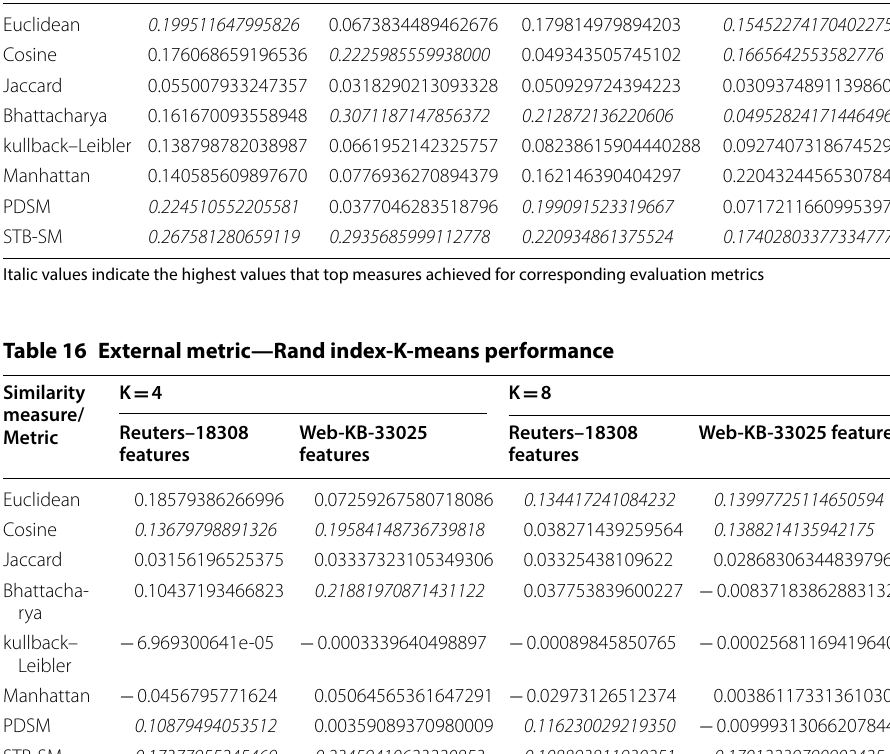
Table 15 External metric—completeness‑K‑means performance